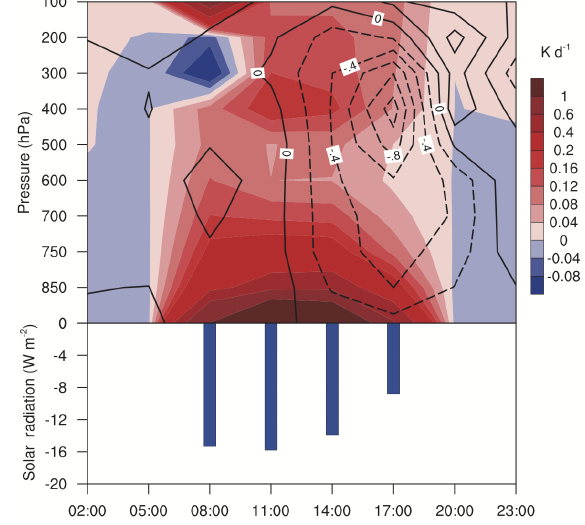
Figure 11. Time–height cross sections of differences between LU70E06 and LU70E70 in radiative heating profile (shade; units: Kd − 1 ) , vertical velocity (contour; units: 10 − 2 ms − 1 ) , and surface solar radiation (blue bars; units: Wm − 2 ) averaged over the three city clusters (Nanjing, Shanghai, and